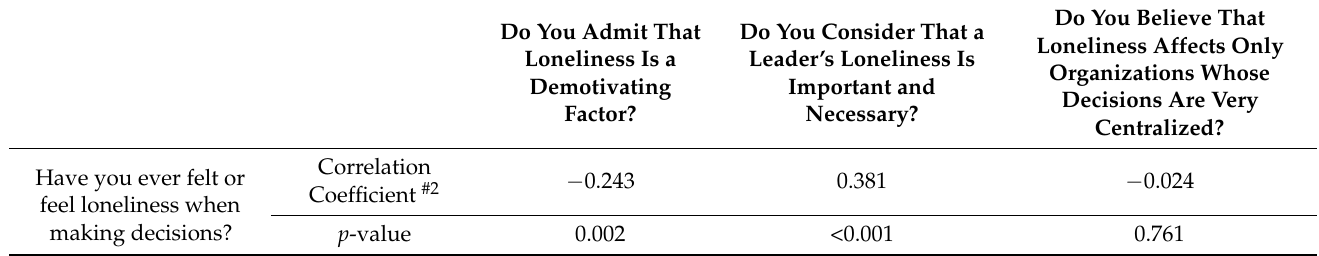
Have you ever felt or feel loneliness when making decisions?